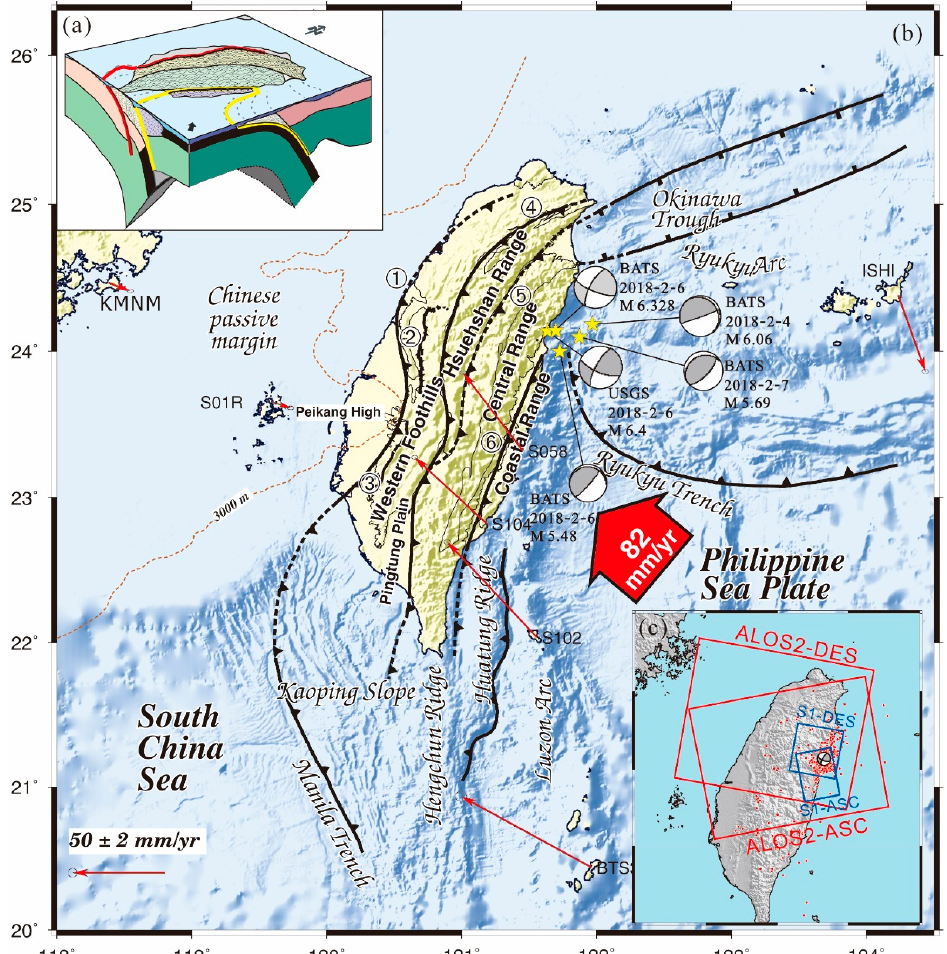
Figure 1. ( a ) Tectonic setting of Taiwan characterized by opposing subduction systems in the north and south [9]. ( b ) Main fault systems (the black lines) of Taiwan orogeny. Seven GPS sites (red arrows) located at the Eurasia and Philippine Sea plates are got from the previous study [10], which show a NW directed block motion with an average velocity of ca. 8.2 cm/year [10]. The yellow star indicates the epicenter of the 2018 Hualien earthquake, and the beach balls are the focal mechanisms of the main shocks and major aftershocks of the 2018 Hualien events solved by USGS and BATS based on the New Automatic Full-Waveform Regional Moment Tensor Inversion Algorithm [11]. ( c ) SAR coverages (the red and blue lines) and aftershocks (red circles) are mapped on the digital Earth model with a high resolution of 30 m.